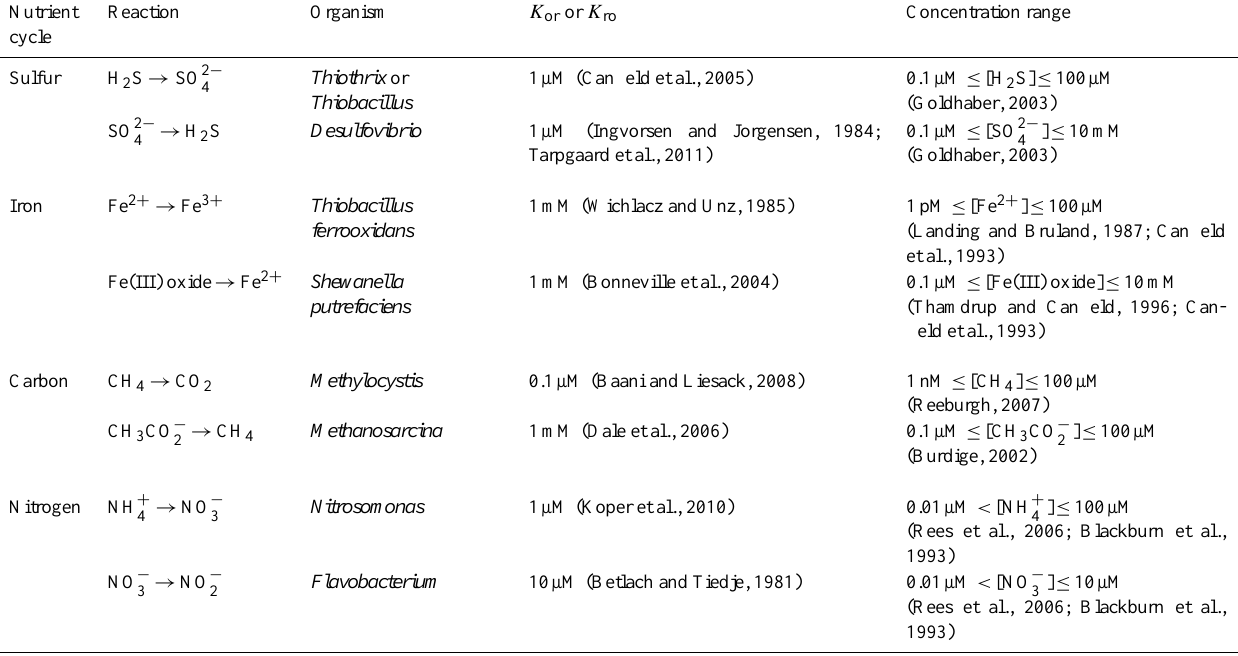
Table 2. Typical values for the half saturation constants K or or K ro for microbial growth, for various nutrient-cycling organisms, compared to typical values for the concentrations of the relevant nutrients in marine environments. All values are given rounded to an order of magnitude. Nutrient Reaction Organism K or or K